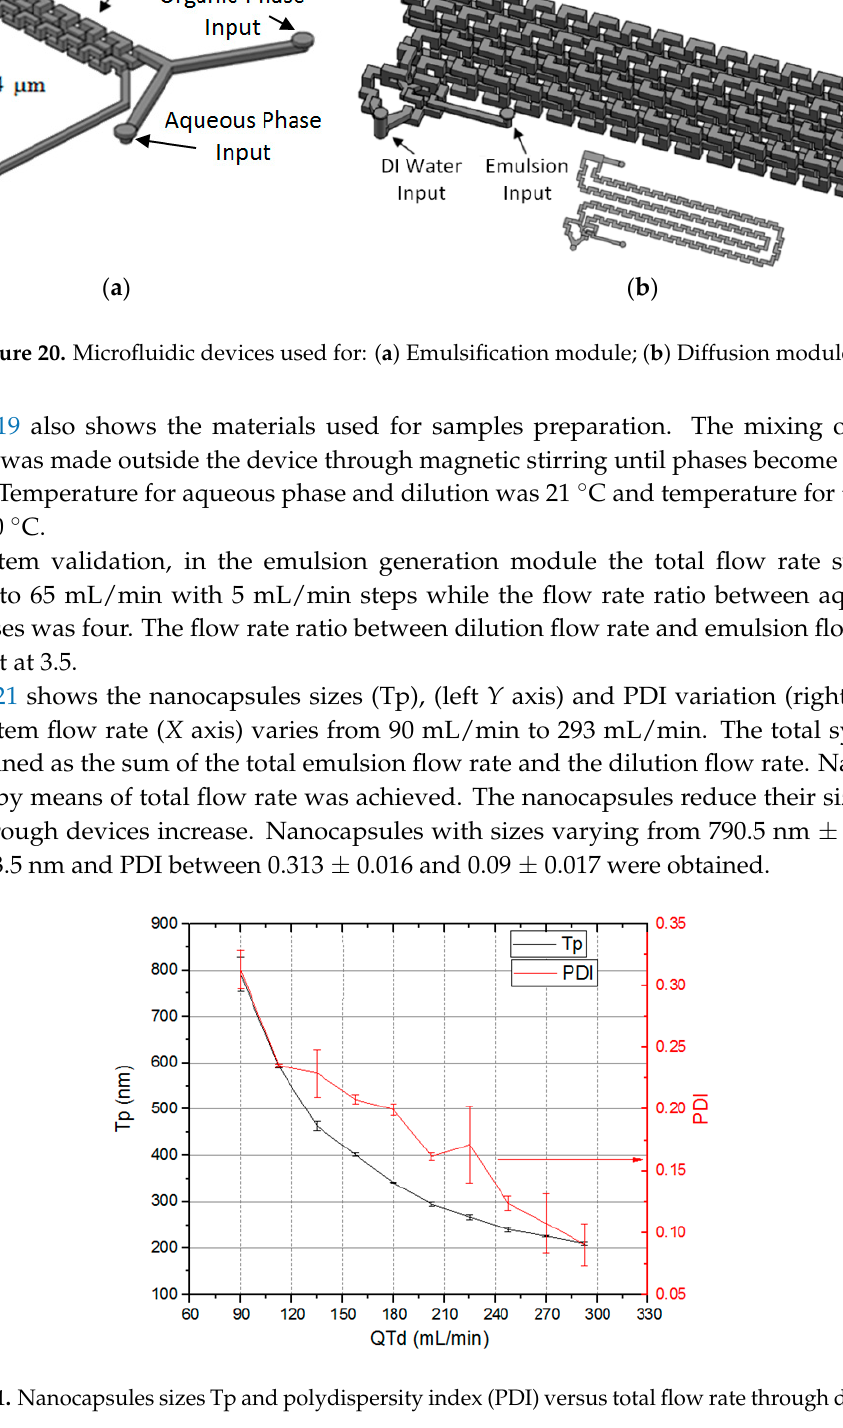
Figure 19. Layout for generation of nanocapsules through a continuous regime microfluidic system.